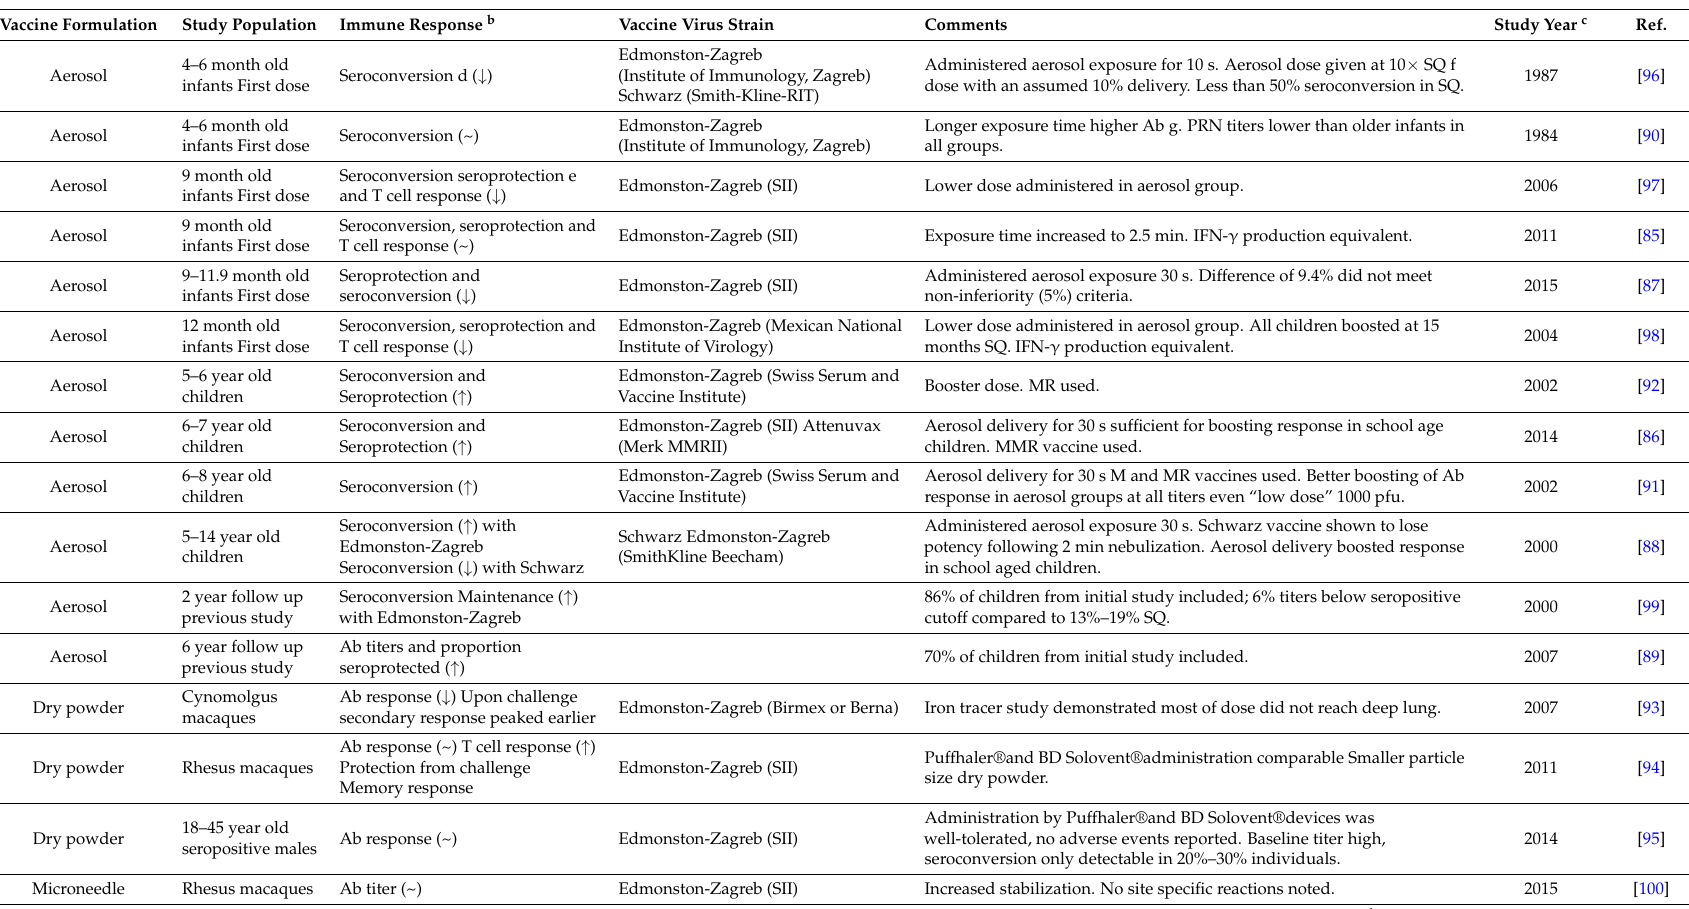
Table 1. Summary of MeV Alternative Vaccination Studies Compared to Subcutaneous Injection a